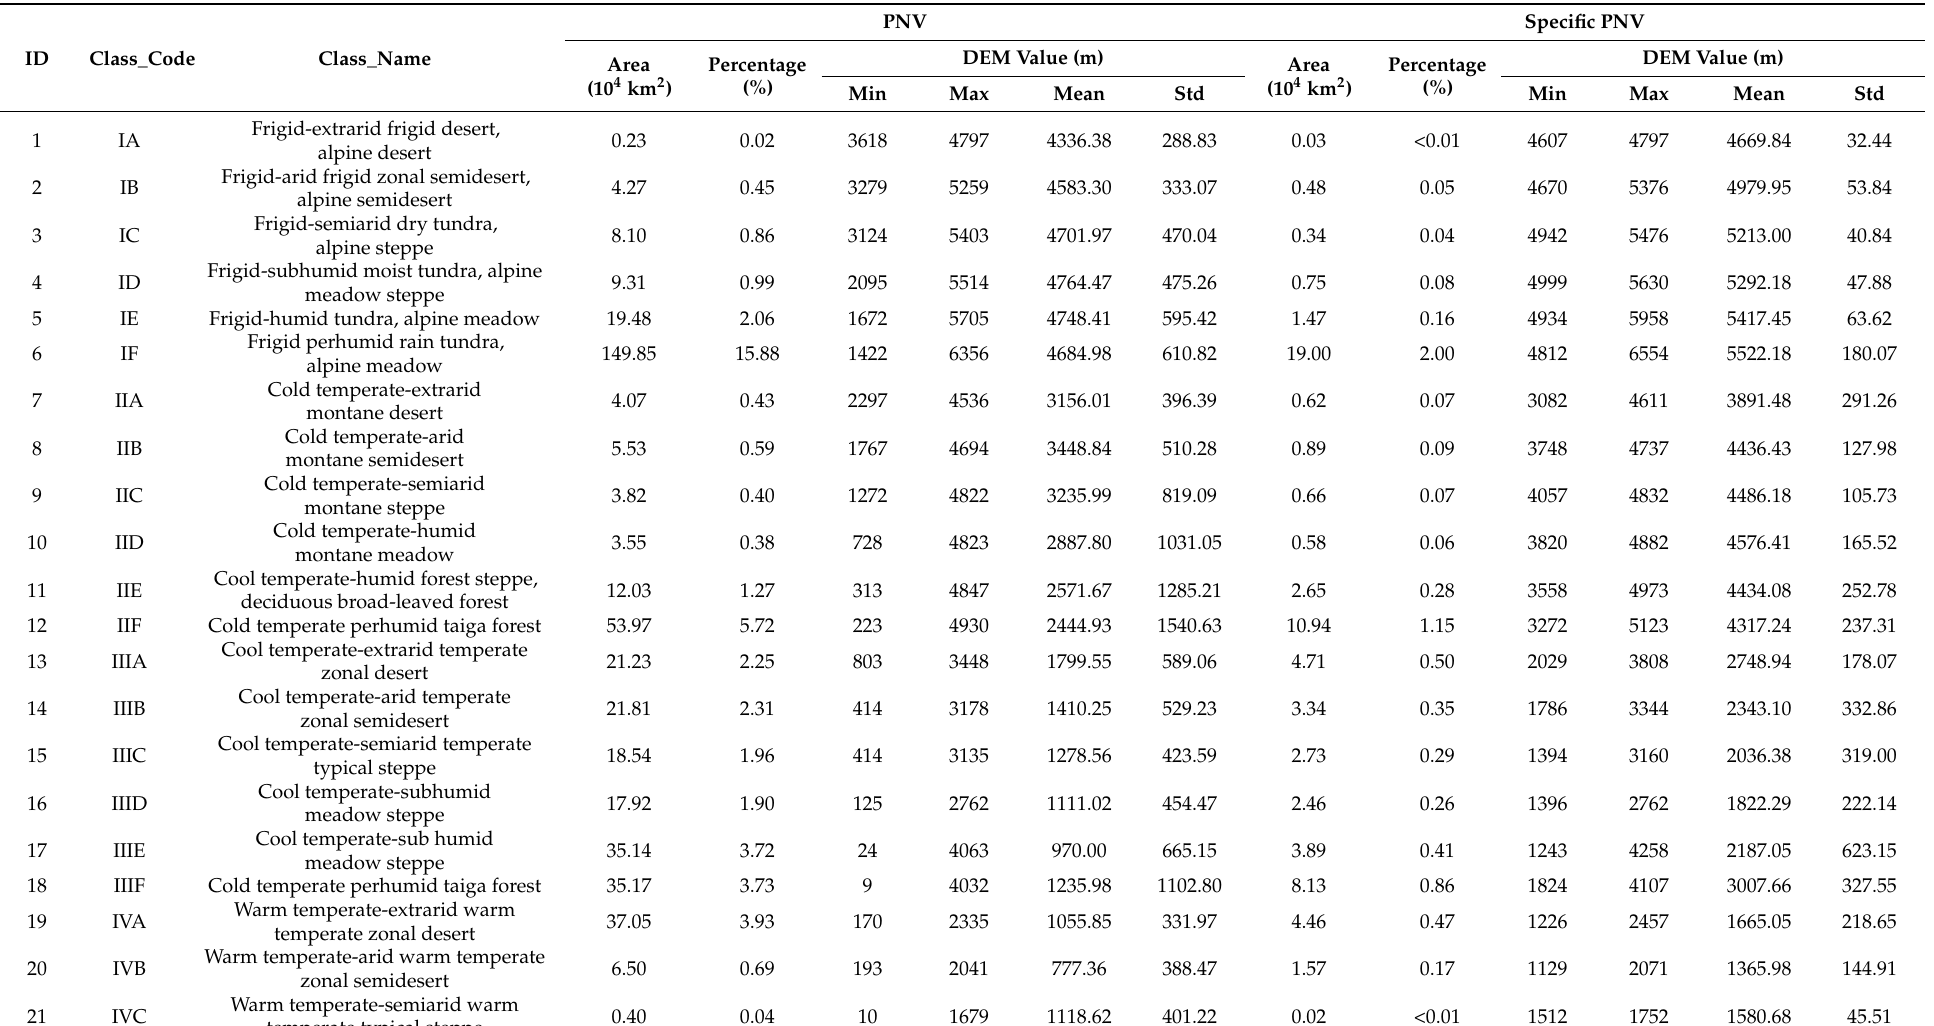
Table A2. The areas, percentage, and DEM of each PNV type in China in the baseline